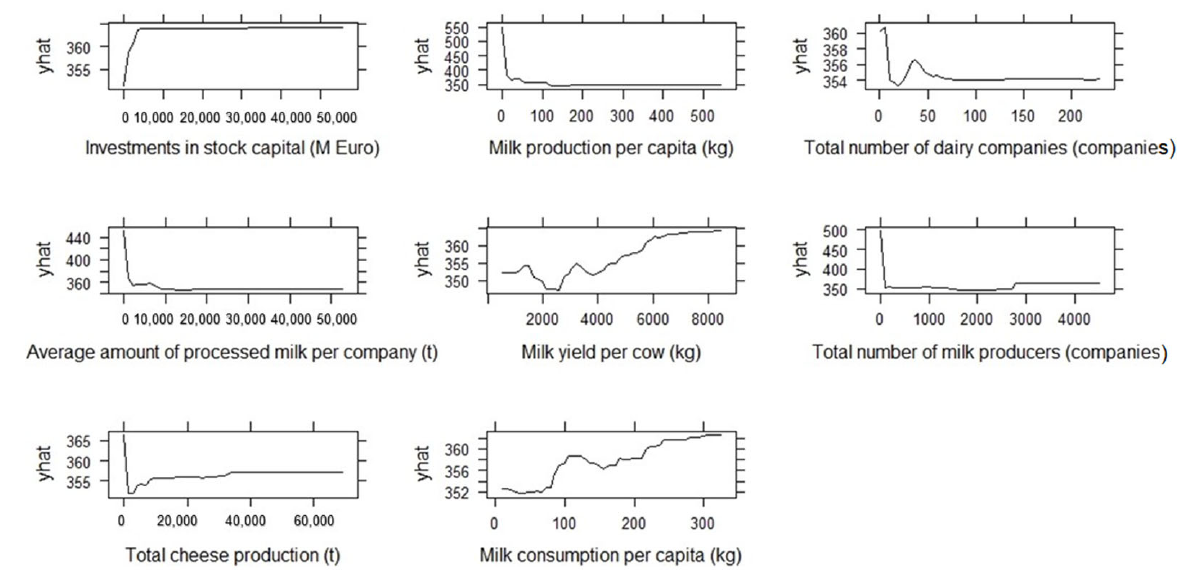
Figure A6. Partial dependence plots (PDPs) for the next eight important predictor variables: invest- ments, milk production, number of dairy companies, amount of processed milk per company, milk yield, number of milk producers, cheese productions and milk consumption. Table A1. Descriptive statistics of the collected